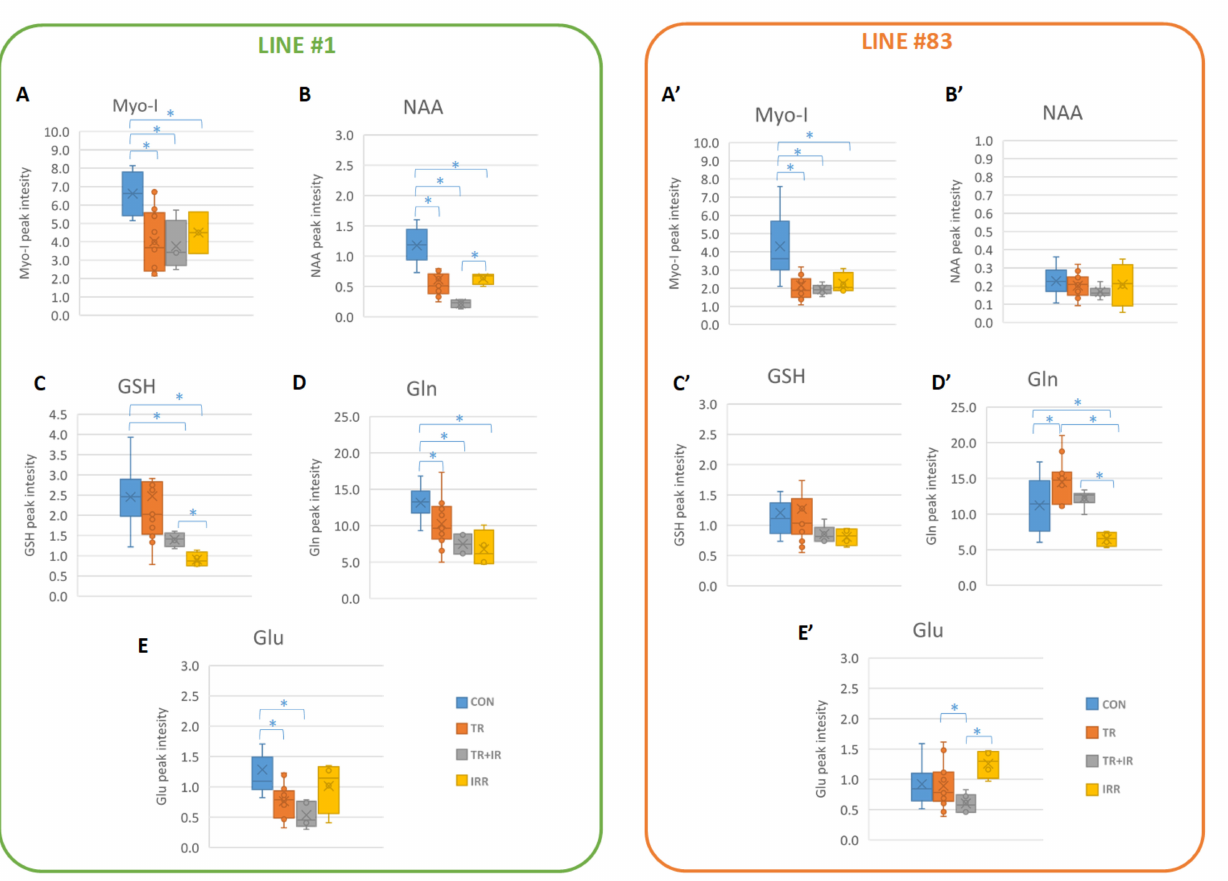
Figure 4. Box and whiskers plot comparing the peak intensity values for metabolites Myo-I ( A , A’ ), NAA ( B , B’ ), GSH ( C , C’ ), Gln ( D , D’ ), and Glu ( E , E’ ) in the four different conditions for line #1 ( A – E ) and line #83 ( A’ – E’ ). Asterisks indicate statistically significant variations (Student’s t test, p value <